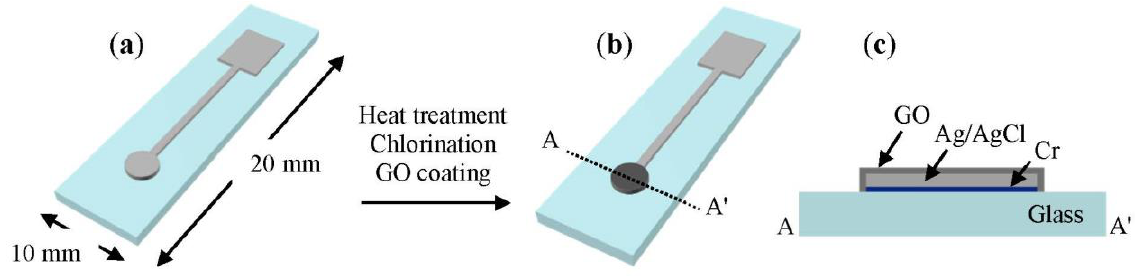
Figure 1. Schematic of the SSRE fabrication process. The sensing part of the electrode is 2 mm in diameter. ( a ) Deposition of Cr and Ag by a sputter process; ( b ) SSRE coated with graphene oxide; ( c ) Cross-sectional view of the